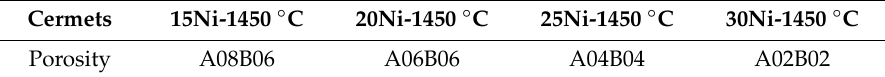
Table 5. E ff ect of the bonder phase addition on the porosities of Ti(C,N)-based cermets.